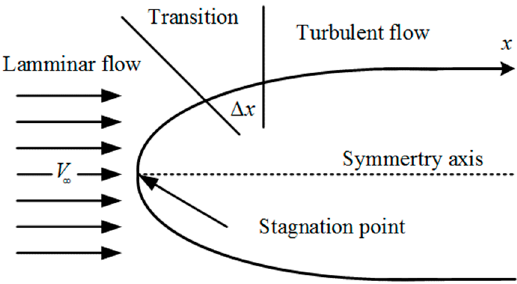
Figure 1. Boundary layer of the axisymmetric body.